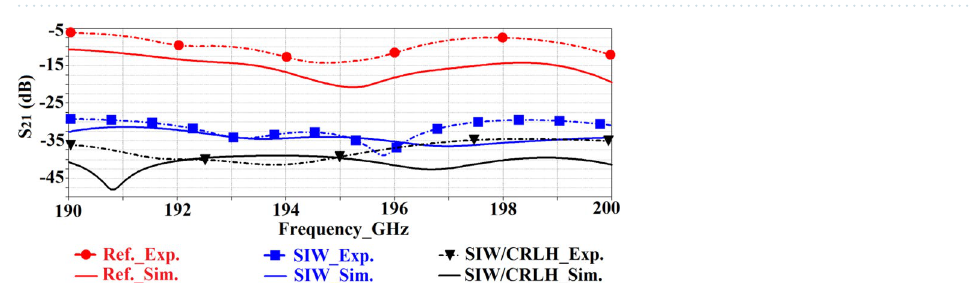
Figure 13. Simulated and experimental results of the reflection-coefficient of the reference, SIW-loaded, and SIW-loaded MTM (CRLH) antenna